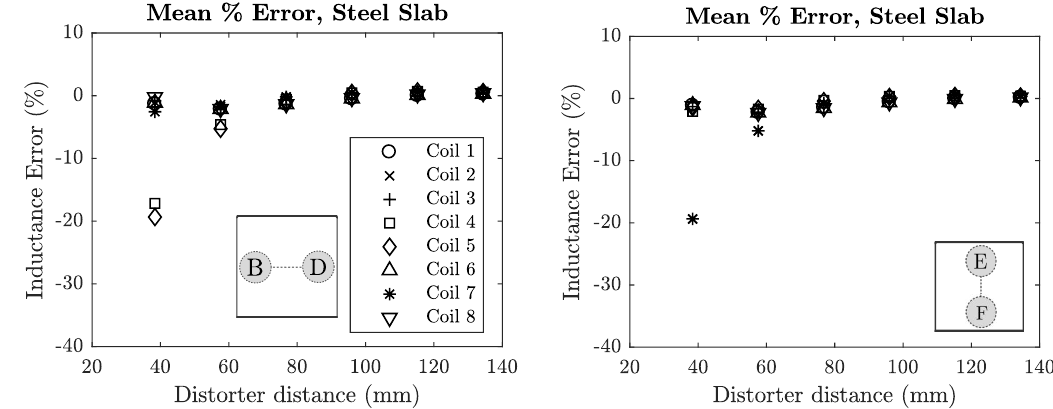
Figure A5. Mutual inductance error plots for steel slab in locations B to D and E to F. The effect is similar to that of the aluminium cylinder, with the highest error experienced by the coils in closest proximity to the